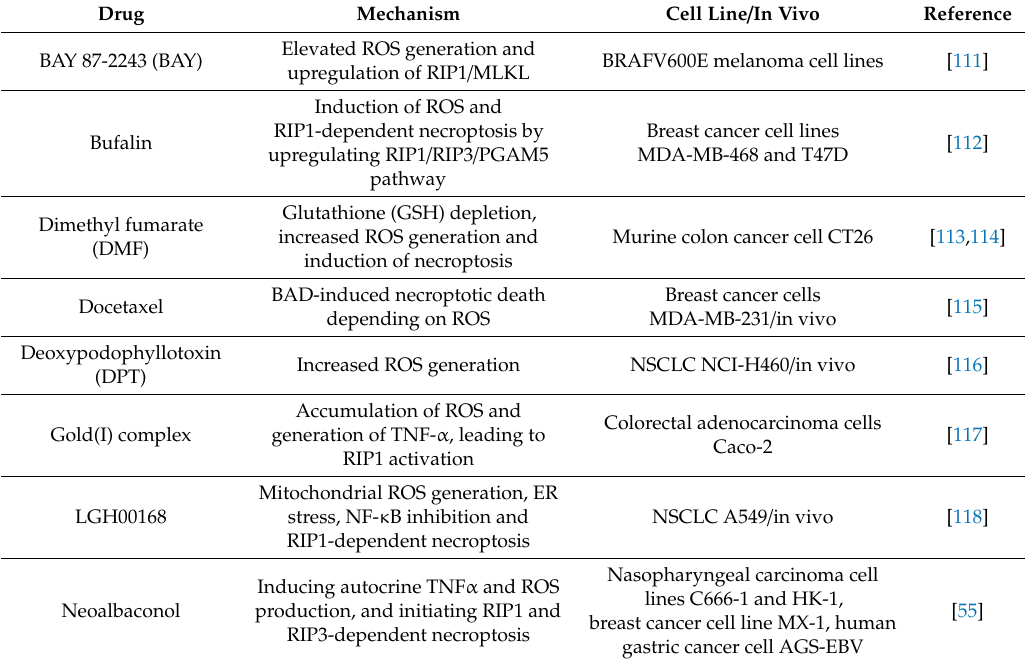
Table 2. Treatments targeting both ROS and